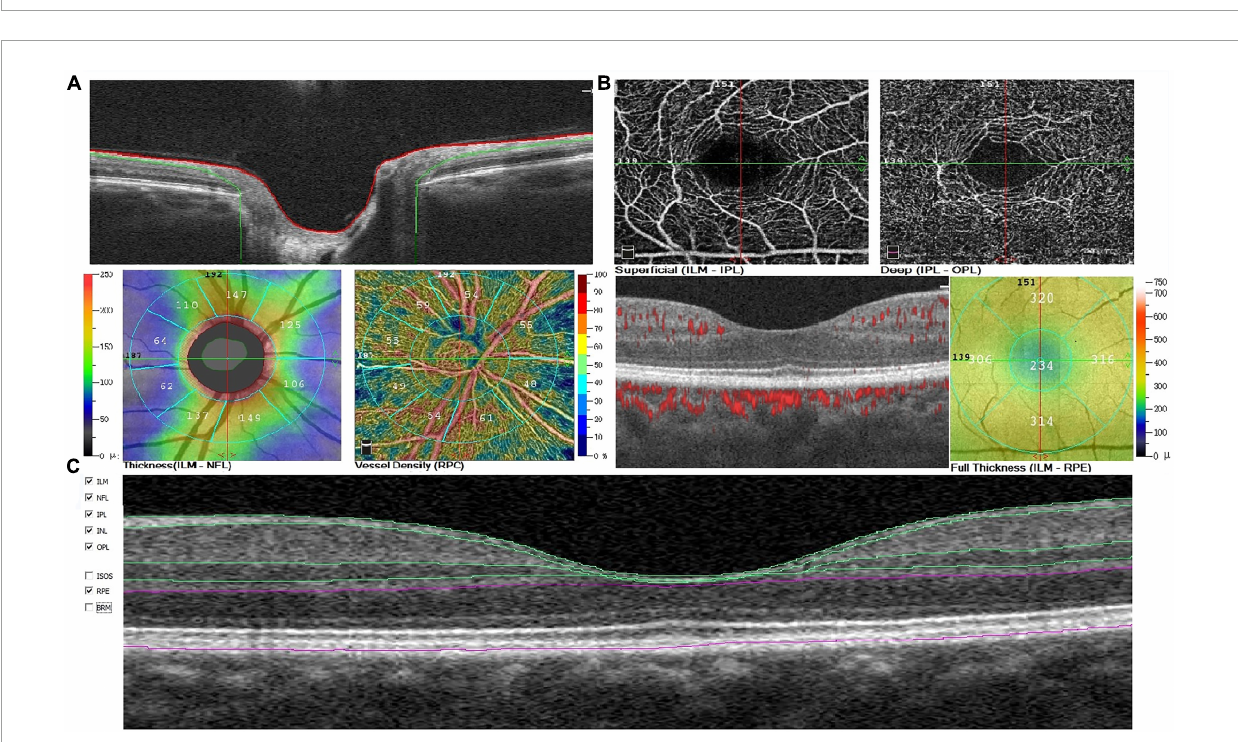
FIGURE2 Example of optic disc (A) , macular (B) changes, and macular sublayers (C) automatically segmented by the AngioVue software in a patient with mild AD. AD, Alzheimer’s disease; RPC, radial parapapillary capillary; ILM, internal limiting membrane; NFL, nerve fiber layer; IPL, inner plexiform layer; INL, inner nuclear layer; OPL, outer plexiform layer; RPE, retinal pigment